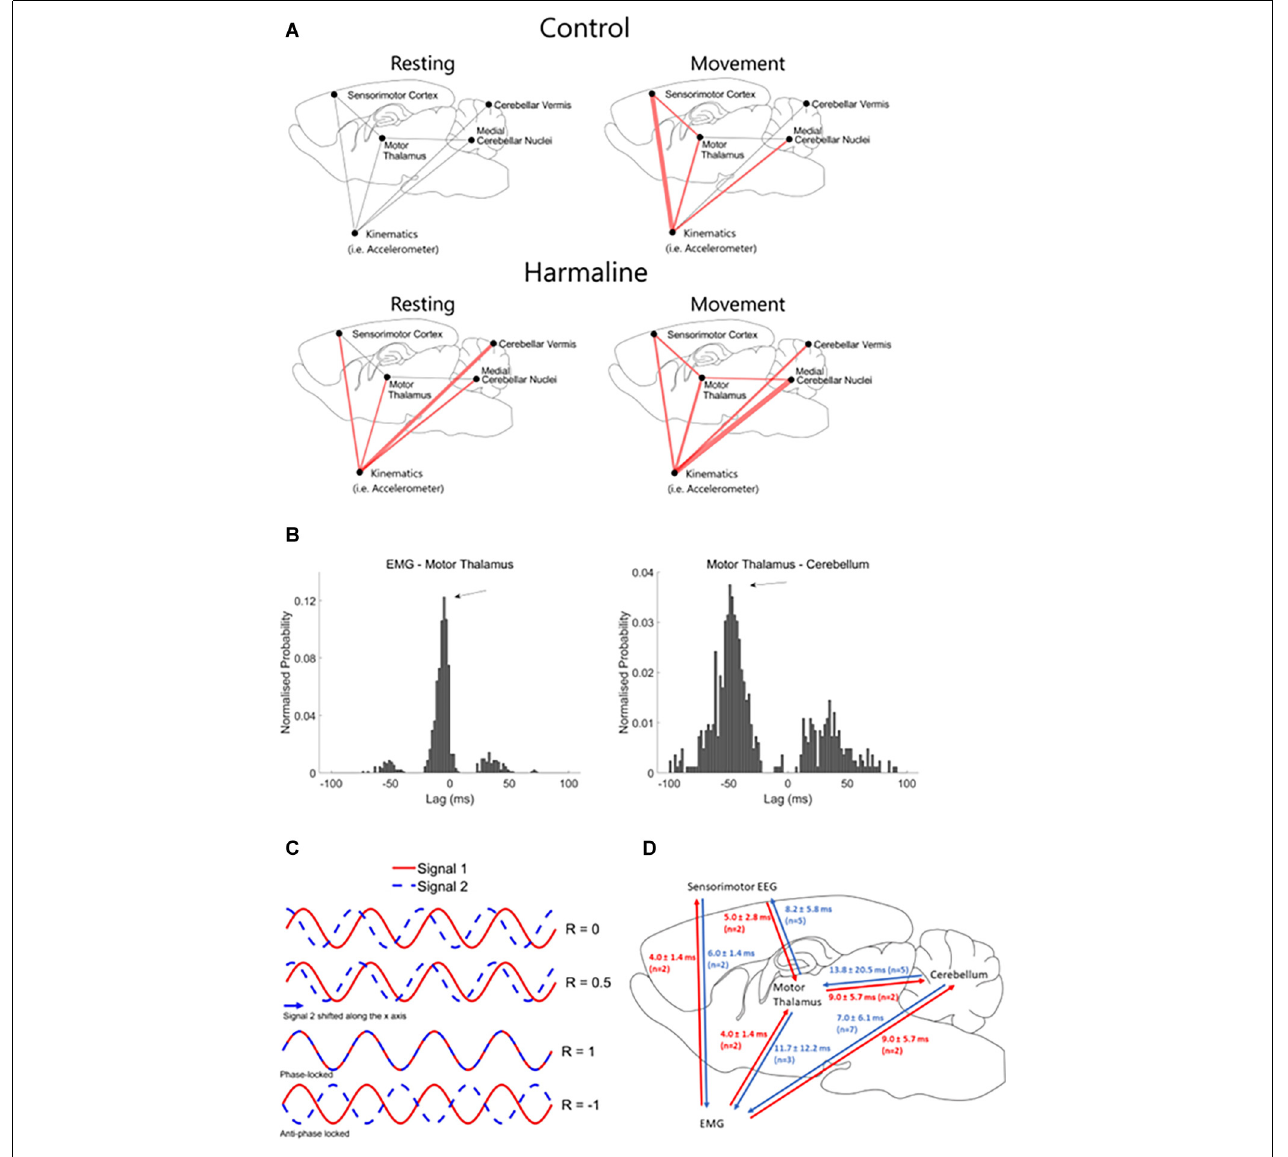
FIGURE 9 | Changes in connectivity across the medial cerebellar-motor thalamus-cortical network. (A) Surrogate analysis of coherence at the tremor frequency (9–15 Hz) during control (rest and move) and harmaline (rest and move). Red lines indicate significantly greater coherence at 9–15 Hz for the recorded neural data compared to the mean from 99 surrogate datasets generated using IAAFT, with Holm-Bonferroni adjusted significance levels for multiple comparisons. The width of the red line corresponds with the size of the t-statistic of the one-tailed paired t -tests comparing surrogate and original datasets, where the thicker the line the larger the effect-size. (B) Example histogram displaying the probability of time-lags (ms) with max cross-correlation across 2-s epochs taken during motor activity after harmaline administration for a single rat. Examples are from two different rats, and negative lags correspond to a backward connection between the name pairs. Arrows indicate time-lags with peak probability of max cross-correlation. (C) Schematic of cross-correlation at different time lags for two perfect sine waves at the same frequency. Shifting one signal (e.g., signal 2) relative to the other (e.g., signal 1) influences the correlation coefficient (R), which varies between − 1 (negative correlation) and 1 (positive correlation). A perfect positive correlation is found when the signals are perfectly phase-locked (i.e., perfect alignment of the two sine waves). A perfect negative correlation between these two signals is found when signals are perfectly locked in an anti-phase direction (i.e., the peaks of signal 1 aligning with troughs of signal 2, and vice versa). (D) Schematic showing mean time delays of tremor frequency oscillations across each recording node in the tremor-network. N corresponds to the number of rats included in the summary statistic.